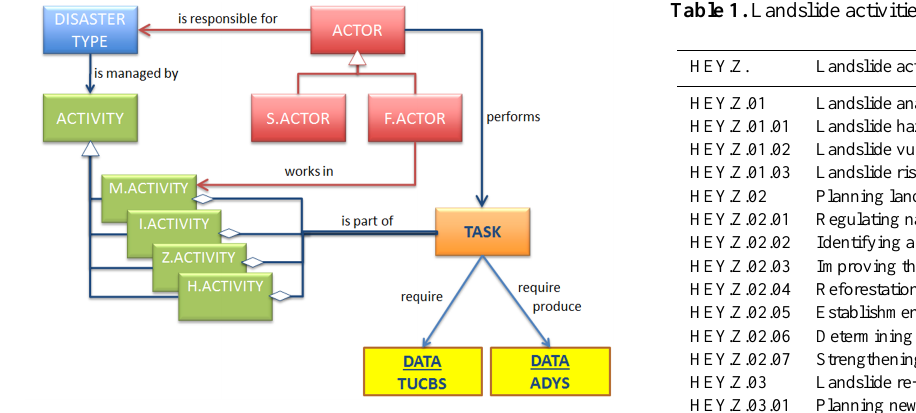
Figure 1. Conceptual model schema for disaster management.